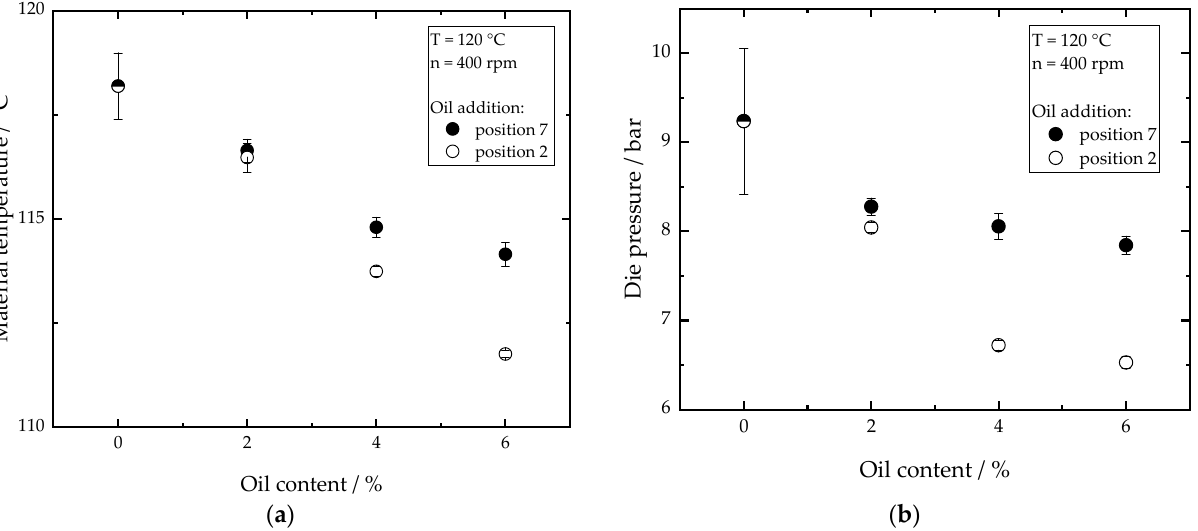
Figure 4. Effect of oil content on the ( a ) material temperature and ( b ) die pressure for oil addition point at position 2 and 7. Total mass flow was 10 kg/h and water content was 51–53% for all samples.